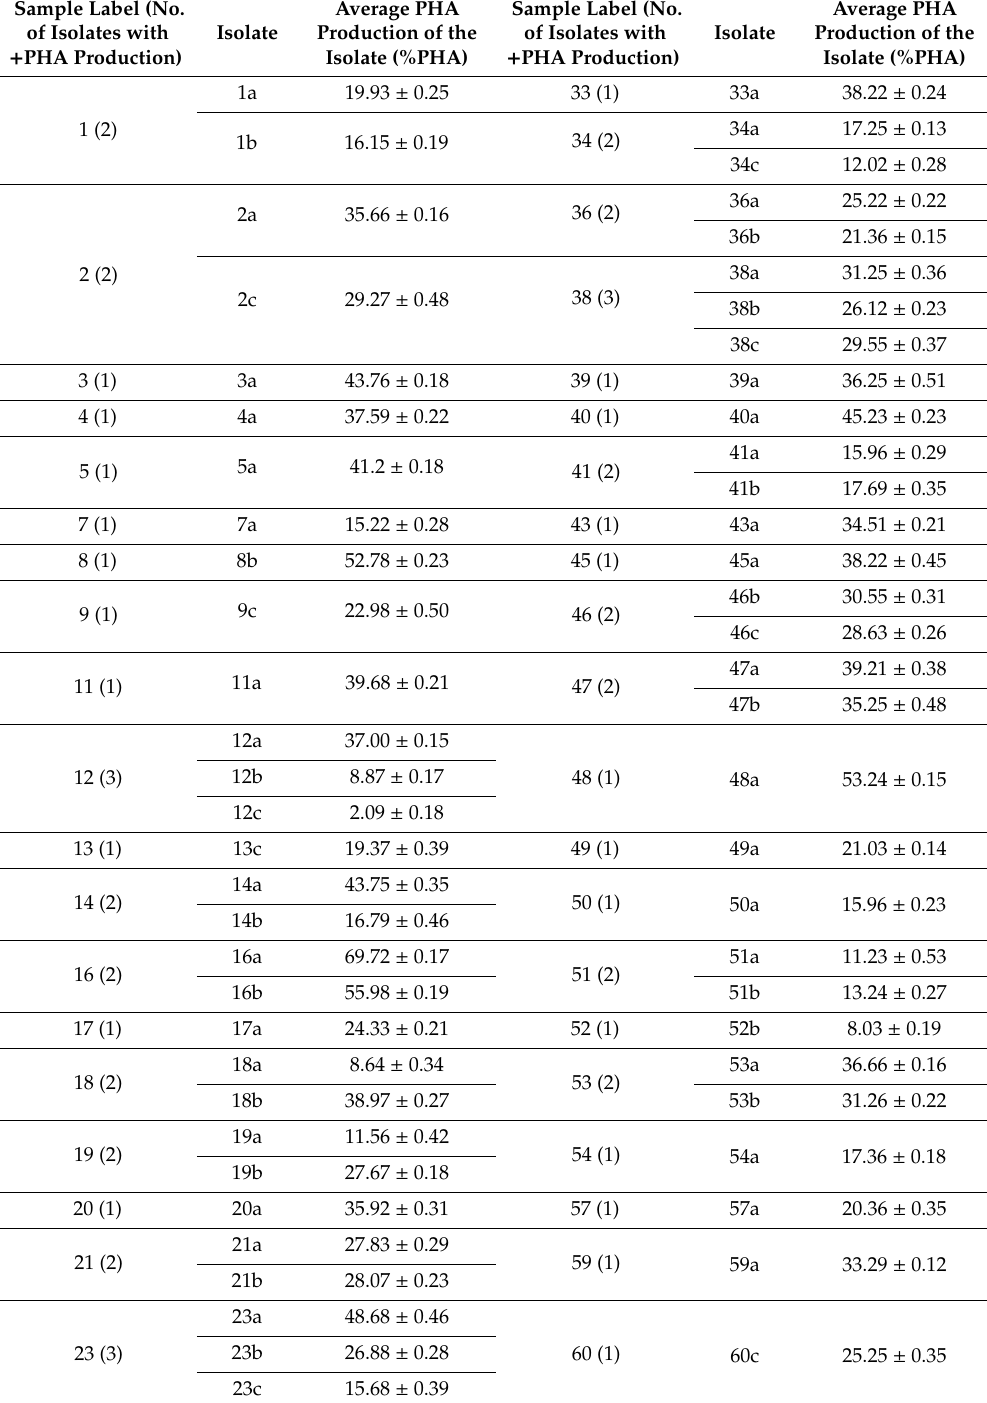
Table 2. Percentage PHA accumulation by isolated strains after submerged fermentation with glucose as a carbon source. Sample Label (No. of Isolates